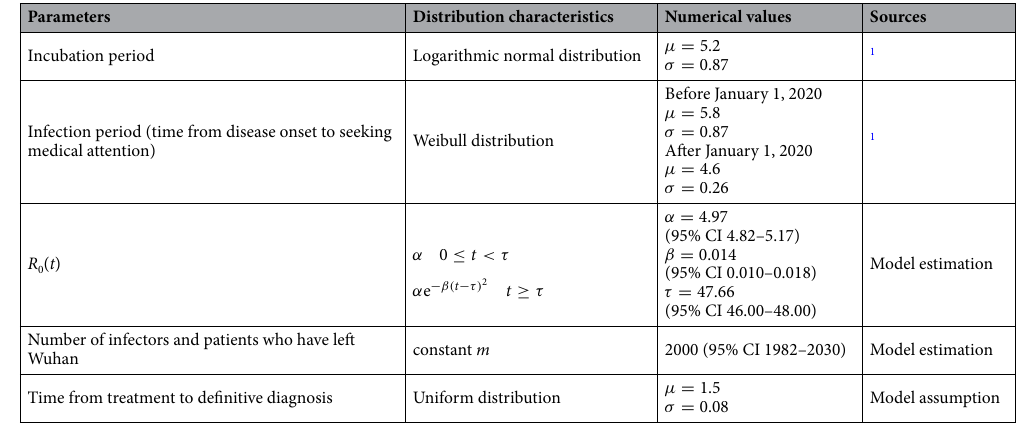
Table 1. Values of model